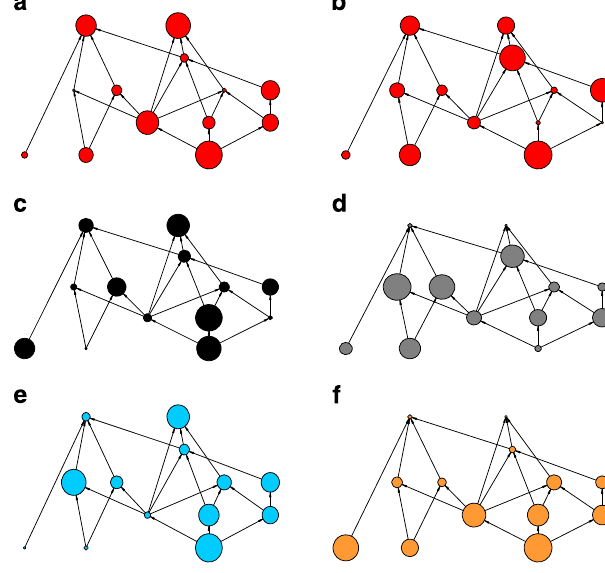
Figure 3 | Priorities for managing the Alaskan food web using different indices/approaches. Optimal A ( a ) and B ( b ) show the optimal prioritization of species for two different assignments of species extinction risk and strength of interaction between species, where species extinction risk (drawn from a Beta distribution with a ¼ 2 and b ¼ 8) and strength of interaction between species (drawn from a lognormal distribution with log- mean—3.0 and log-s.d.—1.5. Optimal A ( a ), Return-On-Investment ( c ), Betweenness Centrality ( d ), Keystone Index ( e ), and Cascading Extinction ( f ) show the prioritization under each of these approaches for the same assignments of species extinction risk and strength of interaction between species. Prioritization rank is indicated by node radius; larger radius equals higher